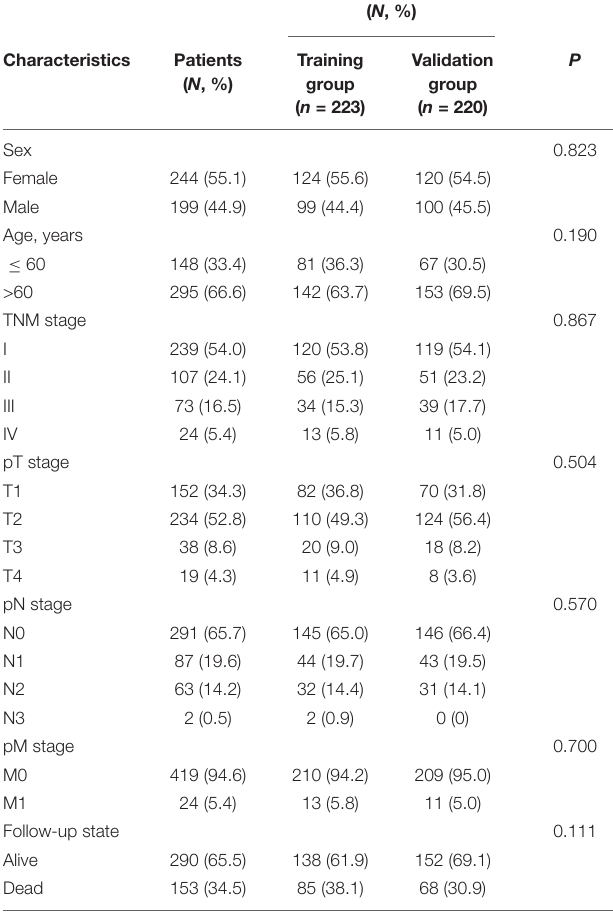
TABLE 1 | Characteristics of patients with